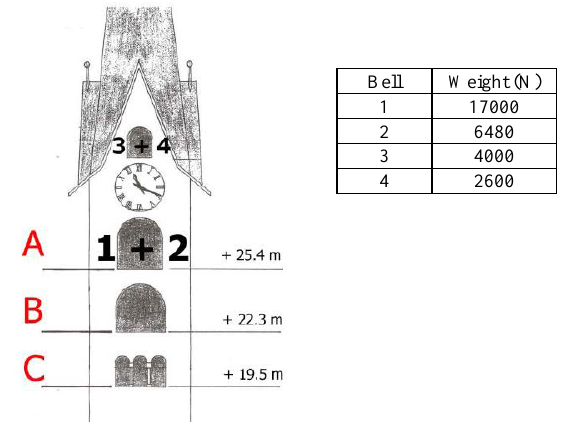
Figure 13. 1st bending mode along X (left) and along Y (right)